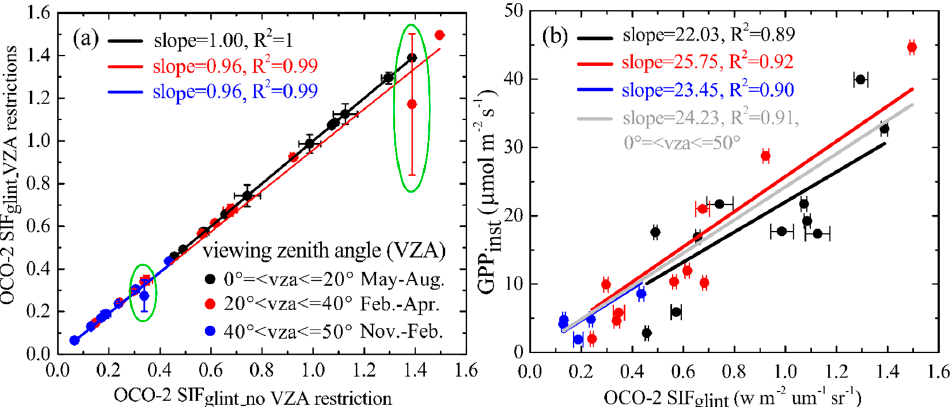
Figure 1. Effects of varying view zenith angle (VZA) on OCO-2 Glint SIF observations and the gross primary production (GPP)–SIF correlation at the mid-day timescale: ( a ) the differences between SIF with and without VZA restrictions: VZA ≤ 20 ° ; 20 ° < VZA ≤ 40 ° ; and VZA > 40 ° ; ( b ) the relationships of ground GPP and SIF under various intervals of VZAs: VZA ≤ 20 ° ; 20 ° < VZA ≤ 40 ° ; VZA > 40 ° ; and no restriction ( 0 ° < VZA ≤ 50 ° ). The data points are averages of the sounding for each